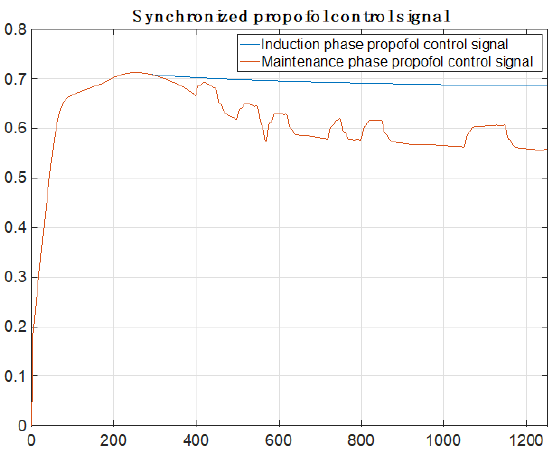
Figure 13. Propofol control signal for the two synchronized controllers (blue—induction, orange— maintenance). Table 5. Final induction-phase performances for each patient.